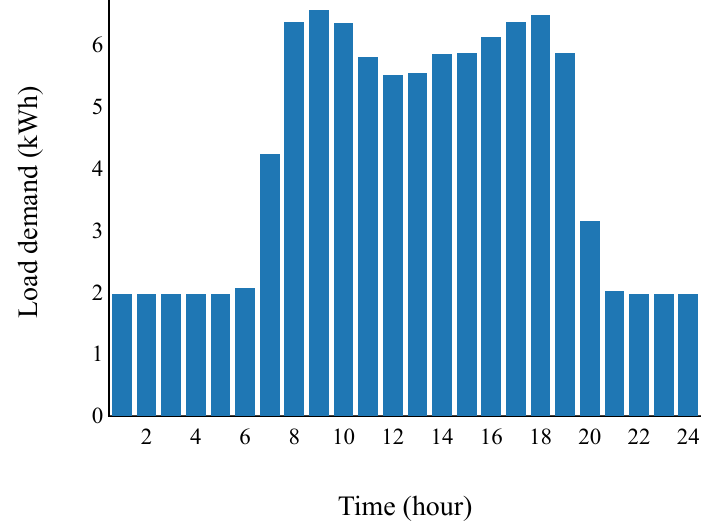
Figure 3. Daily average load profile for one